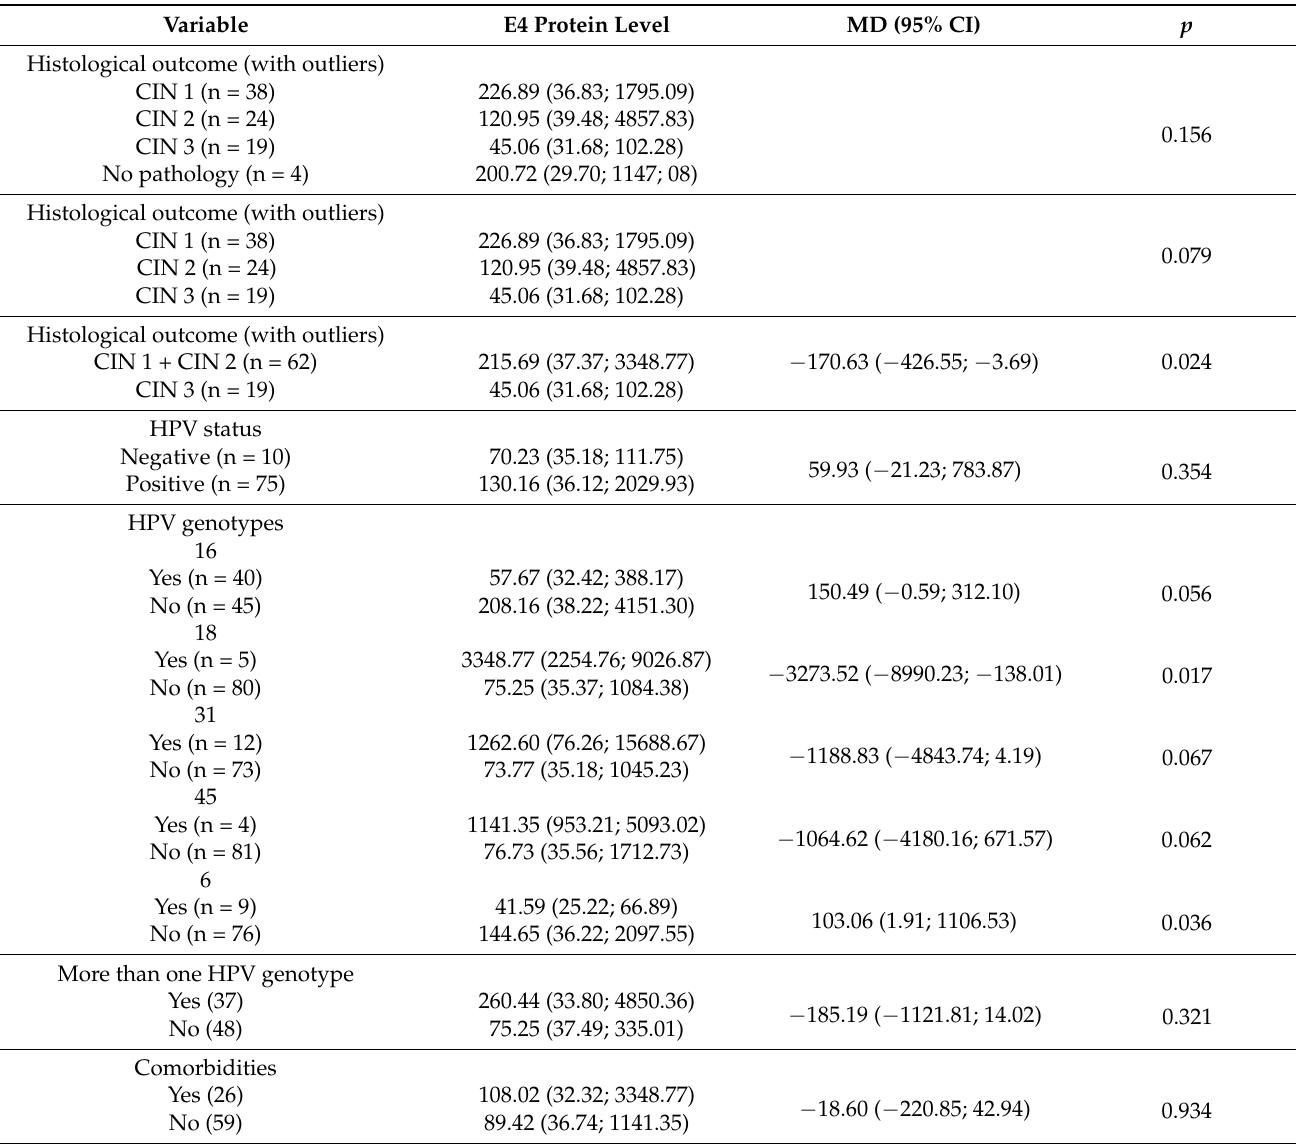
CIN—cervical intraepithelial neoplasia; HPV—human papillomavirus. MD 95% CI—the median difference with the 95% confidence interval. Comparisons were made with the Mann–Whitney U test when comparing the